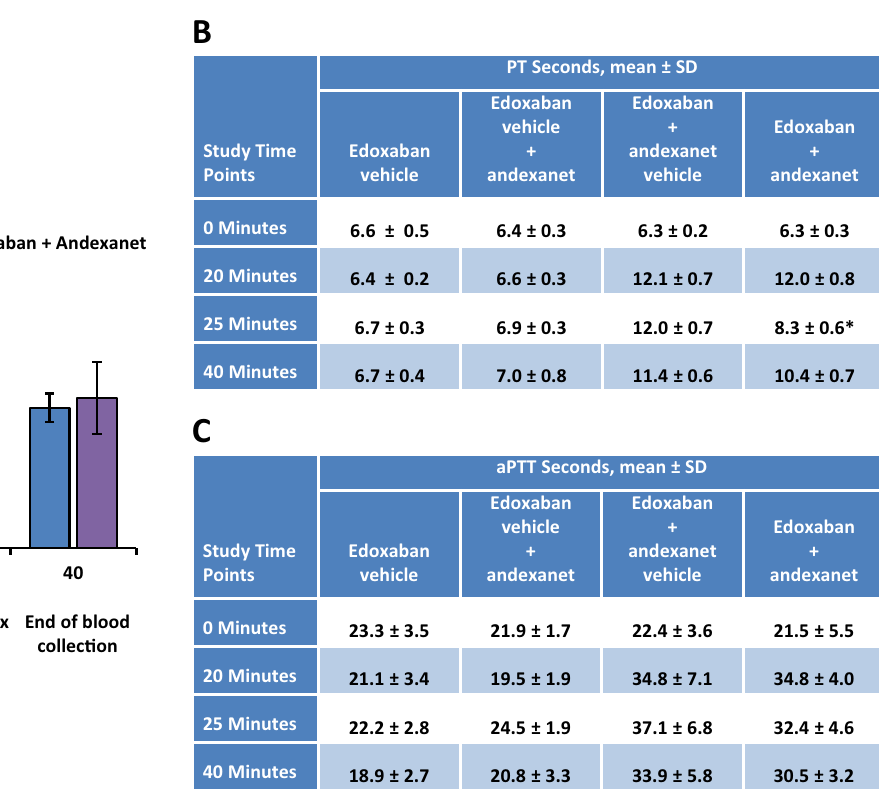
Fig 6. Change in pharmacodynamic parameters following administration of andexanet in edoxaban-anticoagulated rabbits. (A) Edoxaban anti-FXa activity was measured by a modified anti-FXa activity assay. The anti-FXa activity in unknown samples was quantified using the known concentrations of edoxaban in rabbit plasma as standards and expressed as ng/mL. Data are plotted as mean ± standard deviation. (B) PT measurements in seconds. (C) aPTT measurements in seconds. Determination of PT and aPTT was performed on an Instrumentation Laboratory ACL Elite. HemosIL PT-Fibrinogen kit was used for PT measurements, and HemosIL SynthASil kit was used for aPTT